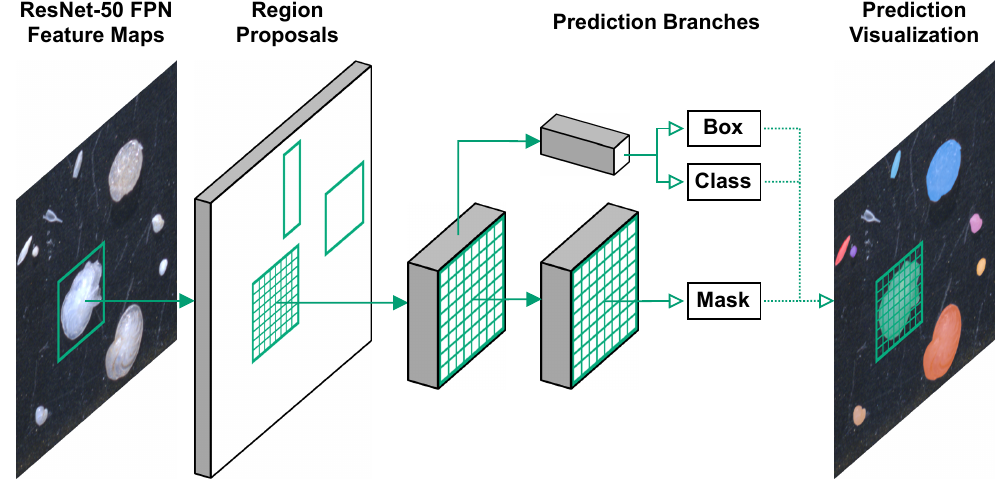
Figure 4. Simple, sketch-like depiction of the Mask R-CNN model